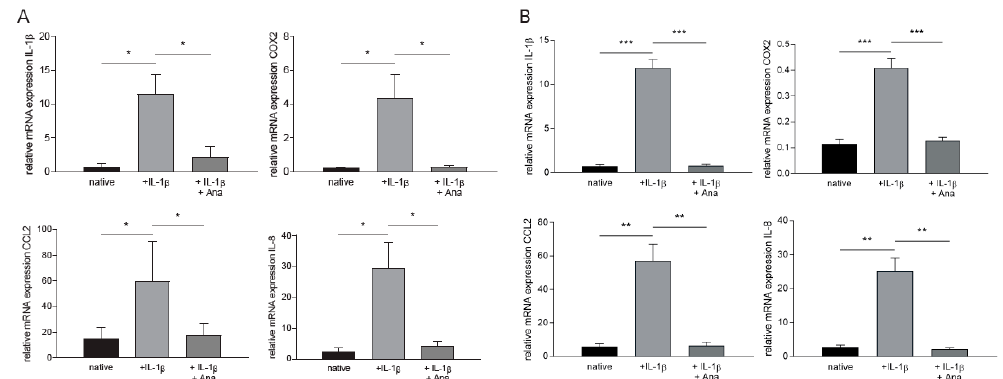
Figure 1. Anakinra dampened IL-1 β -induced inflammatory gene expression in primary glioblastoma (GBM) cells and peripheral blood mononuclear cells (PBMCs). GBM cells and PBMCs were separately stimulated with IL-1 β . Anakinra (Ana) was administered after 3h of incubation. mRNA expression levels of proinflammatory IL-1 β , COX-2 , CCL2 , and IL-8 were quantified by qRT-PCR. (A) mRNA expression of proinflammatory cytokines in GBM (n = 6, p < 0.041). (B) mRNA expression